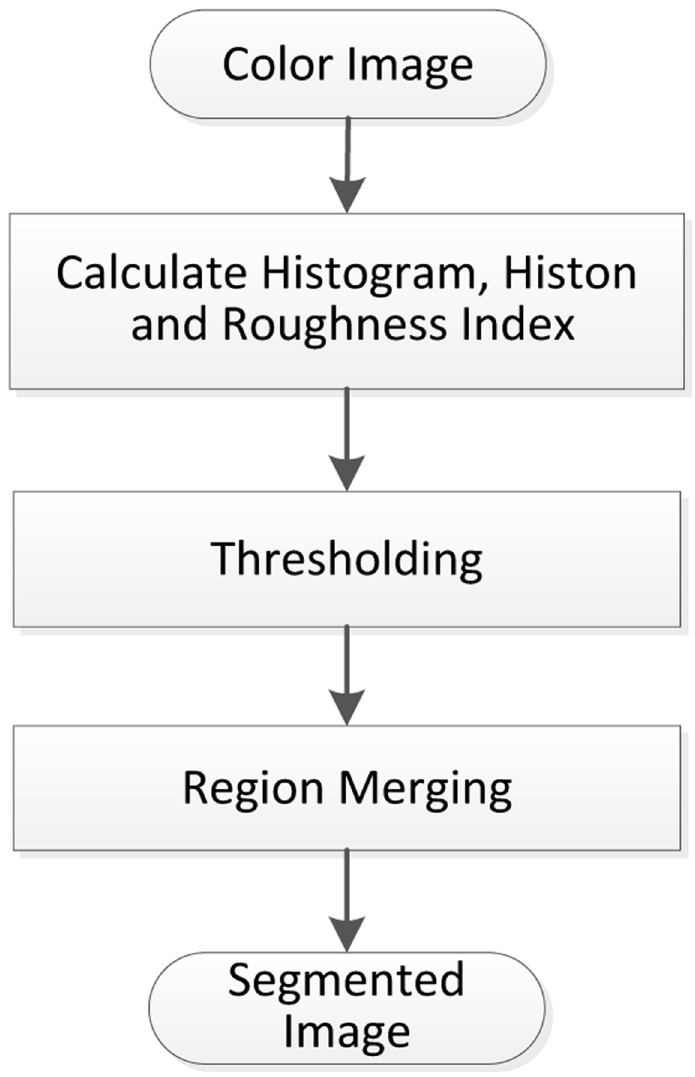
Fig 1. Flowchart of the histogram-based